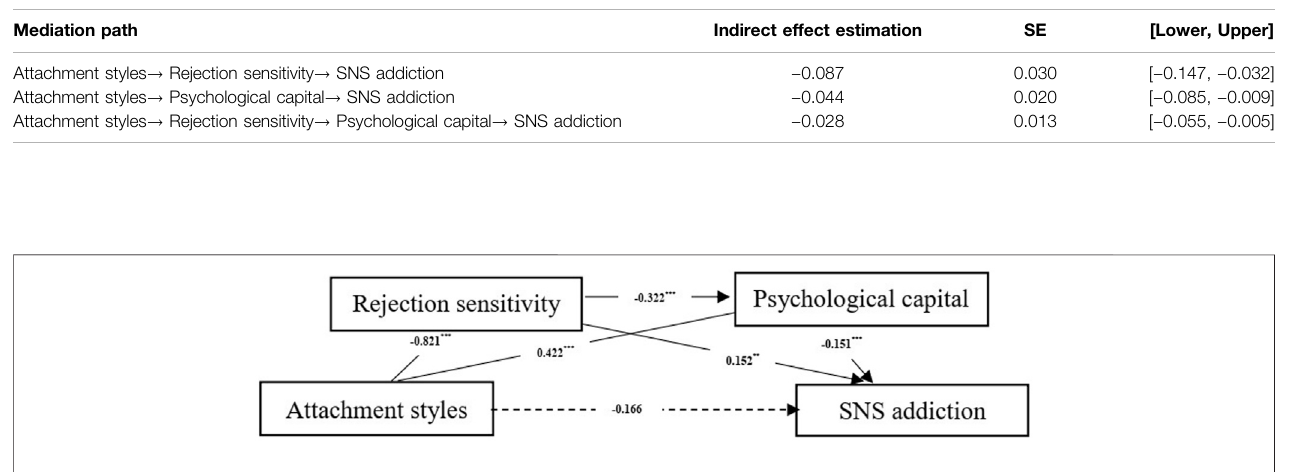
FIGURE 2 | The unstandardized coef fi cients of the